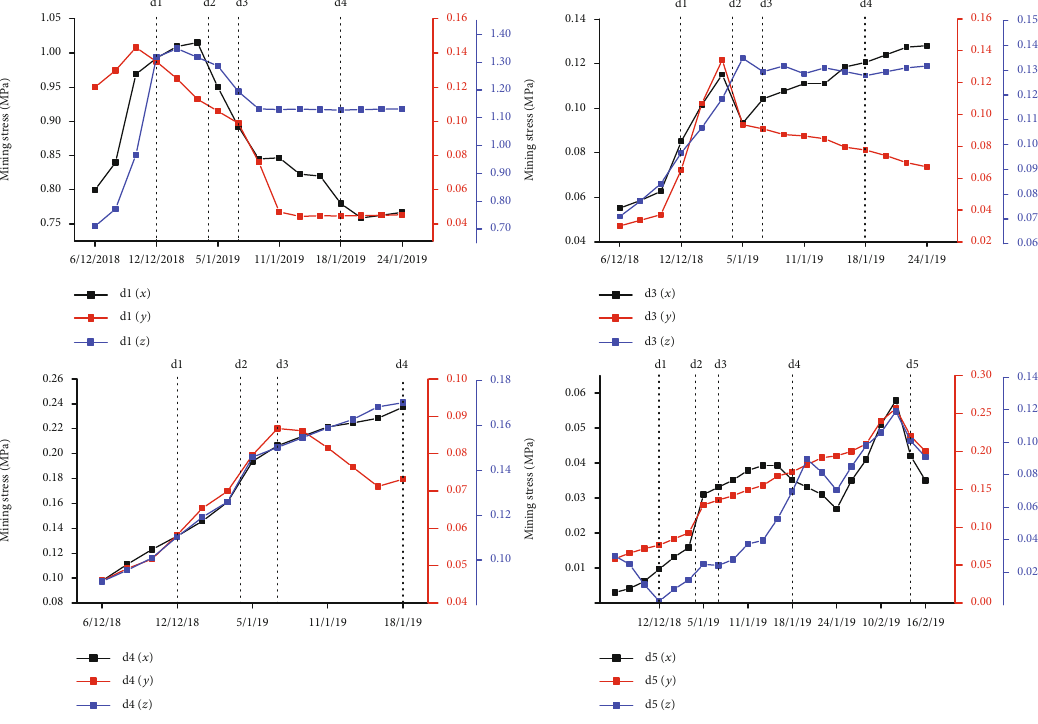
Figure 11: Monitored mining stresses. y = 0.0031 x –132.4